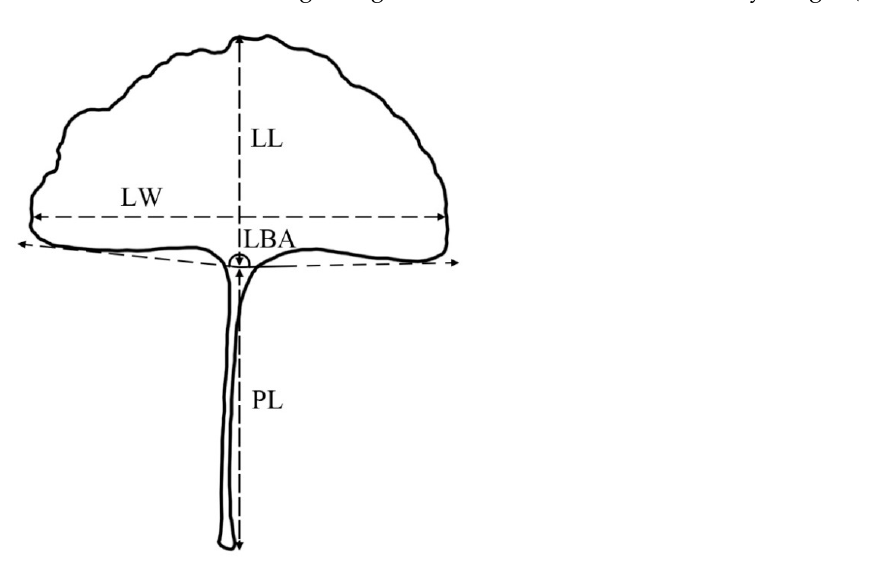
Figure 2. A schematic diagram of the leaf length (LL), leaf width (LW), petiole length (PL) and leaf base angle (LBA).